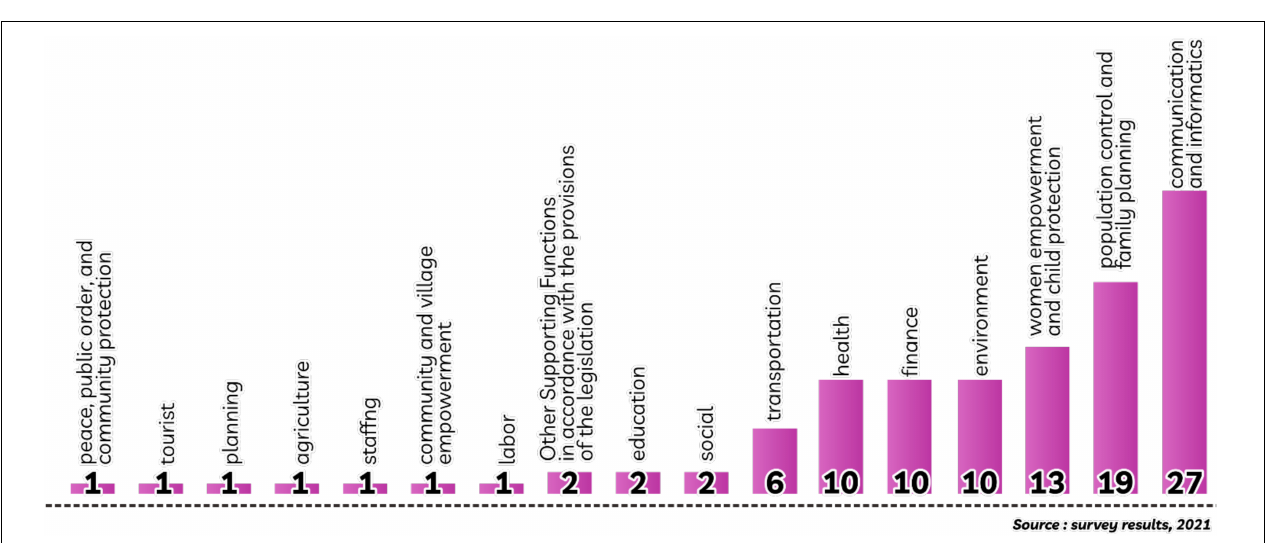
FIGURE 1 | Form, type, initiator of innovations in Keerom Regency.